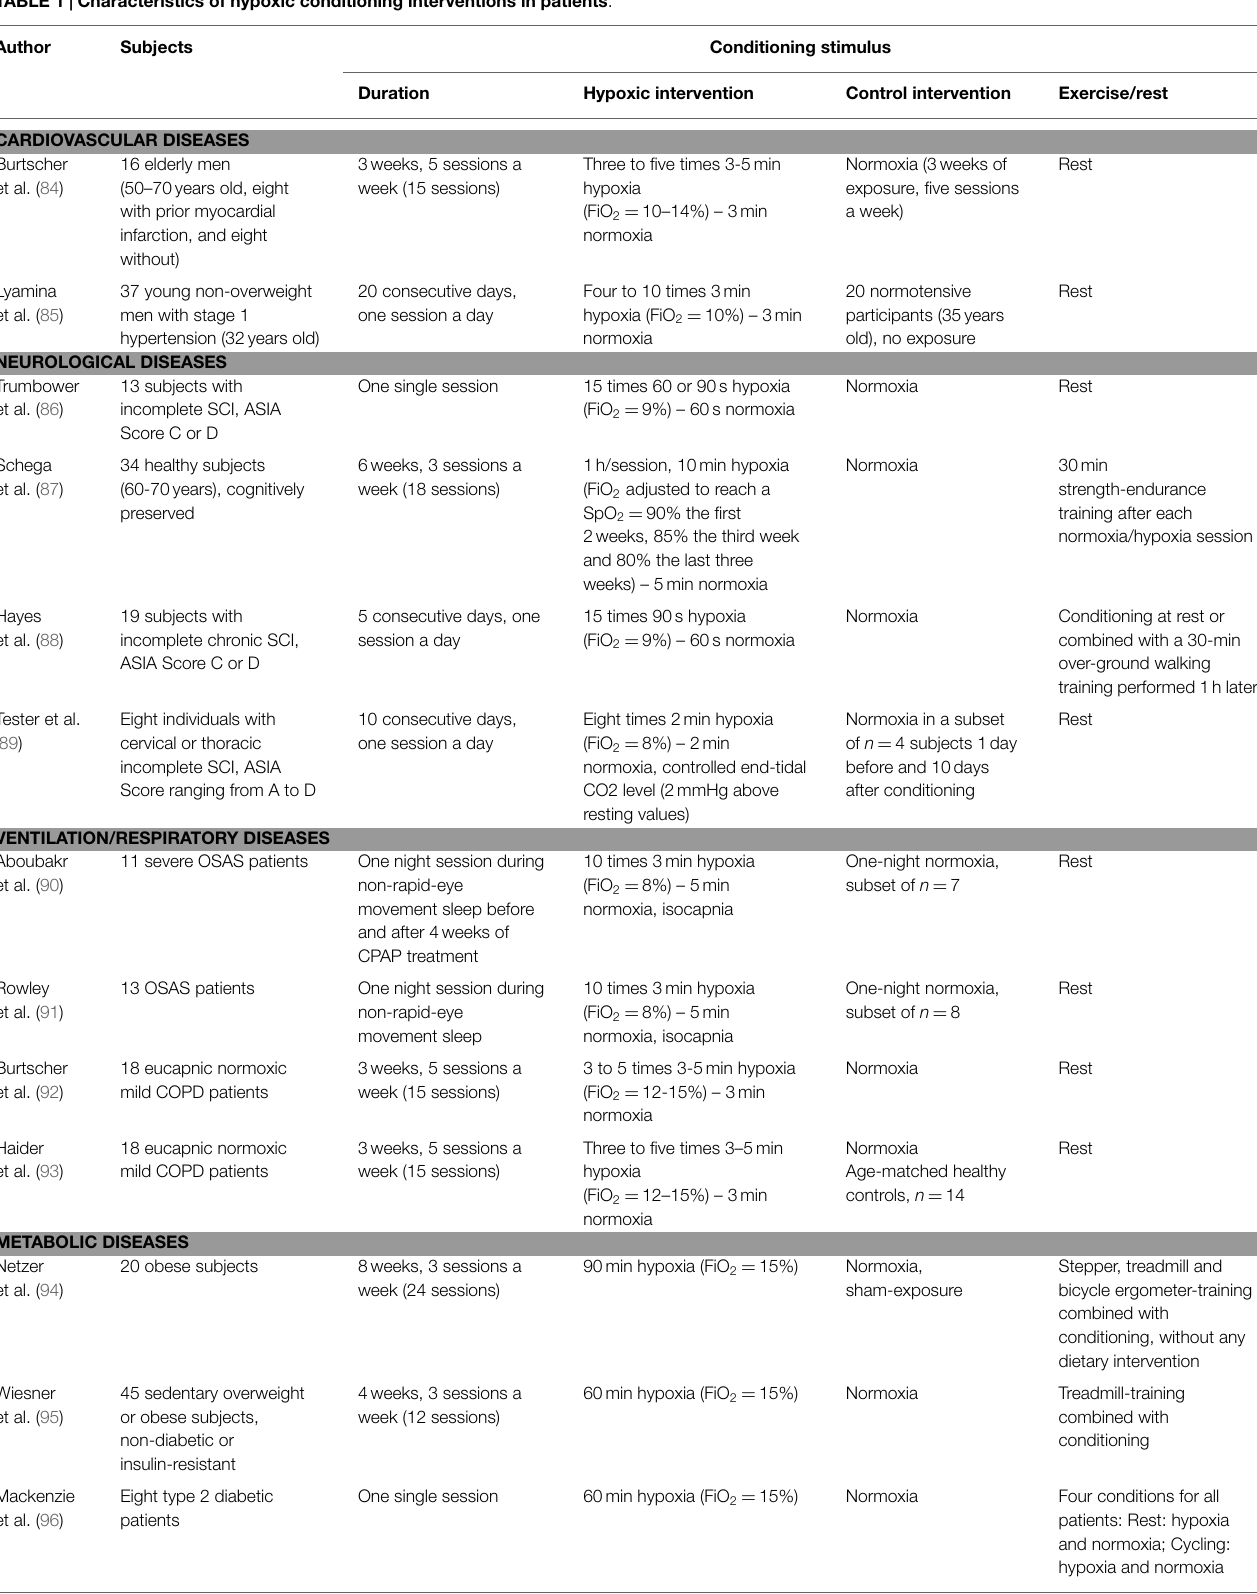
TABLE 1 | Characteristics of hypoxic conditioning interventions in patients